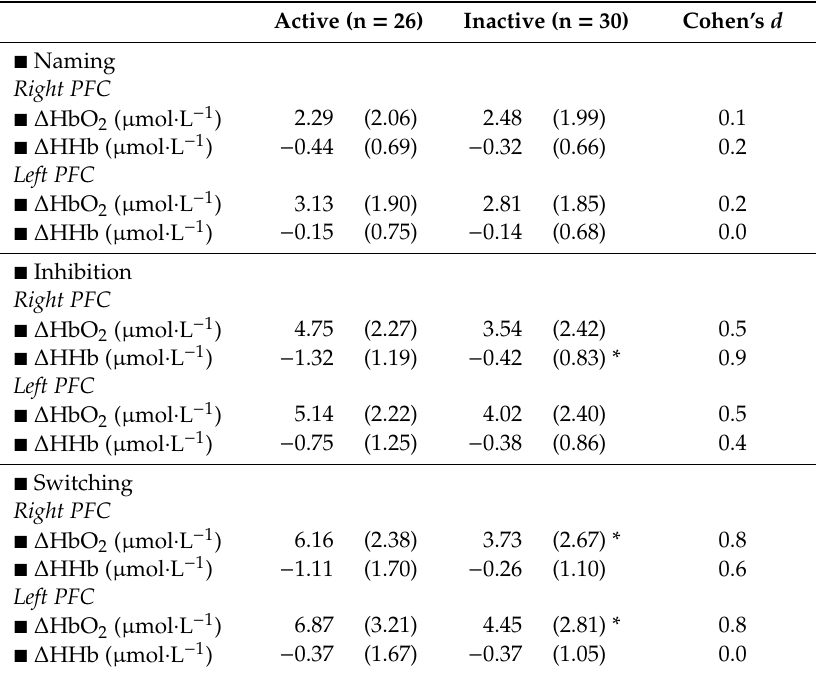
Table 3. Right and left prefrontal cerebral oxygenation changes from baseline during computerized Stroop tasks. Data are presented as means (SDs).